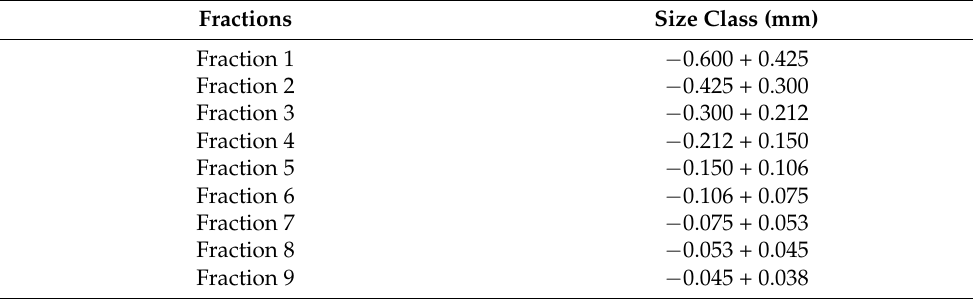
Table 1. Particle size range of the grinding products.